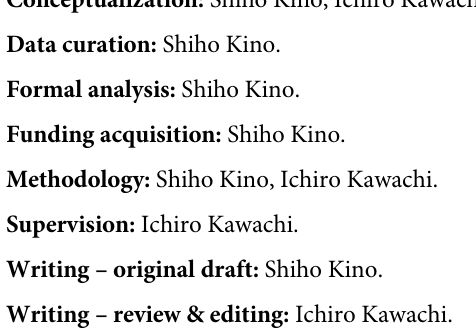
S1 Table. Classification of expansion and non-expansion states. S2 Table. Mean Slope Index of Inequality (SII) and mean Relative Index of Inequality (RII) for expansion and non-expansion states before and after ACA